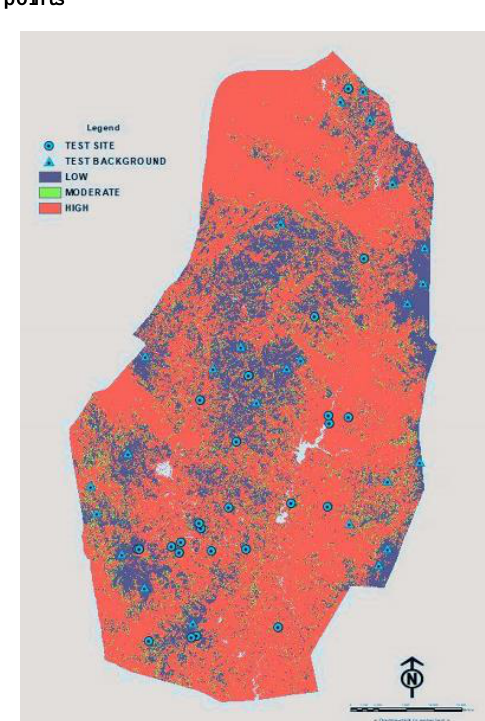
Figure 8. Site and non-site points overlaid on the generated map.